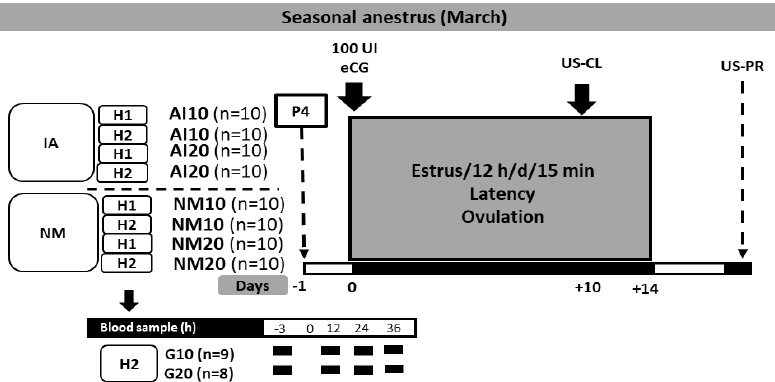
Figure 1. Experimental design of the ultra–short protocol based on P4 + eCG in crossbred adult anestrous goats (Saanen-Alpine-Nubian x Criollo, n = 80). Note: H1 = herd 1; H2 = herd 2, P4 = doses of intramuscular P4 either 10 or 20 mg goat − 1 ; goats treated with P4 and exposed to either natural mating (NM10 or NM20) or artificial insemination (AI10 or AI20). All goats were treated with 100 IU eCG, 24 h after P4–administration; (day 0). US–CL = ultrasound to determine the presence of corpus luteums 7 d after the estrus peak. US–PS = ultrasound to determine pregnancy 45 d after breeding. Serum P4 concentration was quantified four times; during the first hour after eCG administration and 12, 24, 36 h